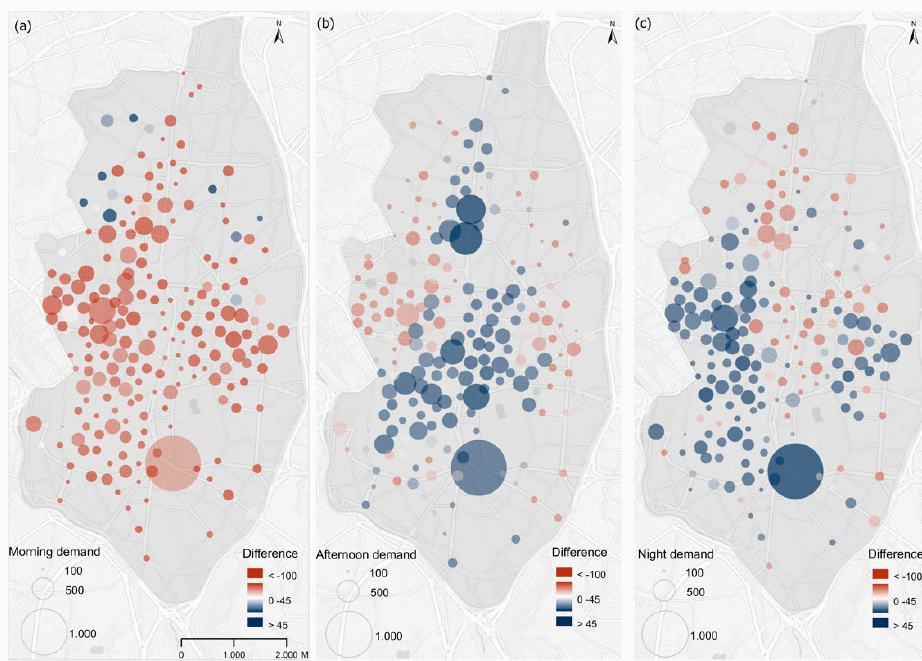
Figure 7. Reference Scenario: Demand covered by each parking space and differences between the time bands in the total demand covered. ( a ) Morning night. ( b ) Afternoon morning. ( c ) Night afternoon.